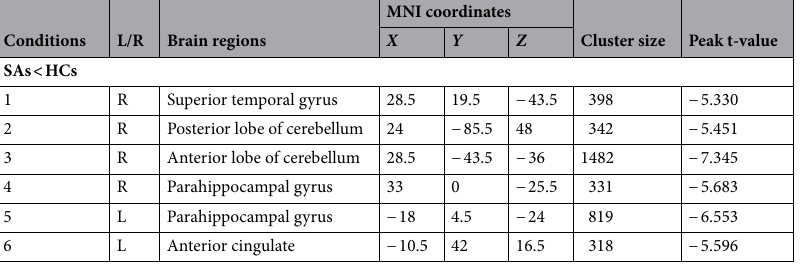
Table 2. Brain areas with significantly group GMV differences between groups. The statistical threshold was set at voxel level with p < 0.01 for multiple comparisons using Gaussian random field theory voxels with p < 0.01. GMV gray matter volume, SA strabismus with amblyopia, HC healthy control, MNI Montreal Neurological Institute, R right, L left.